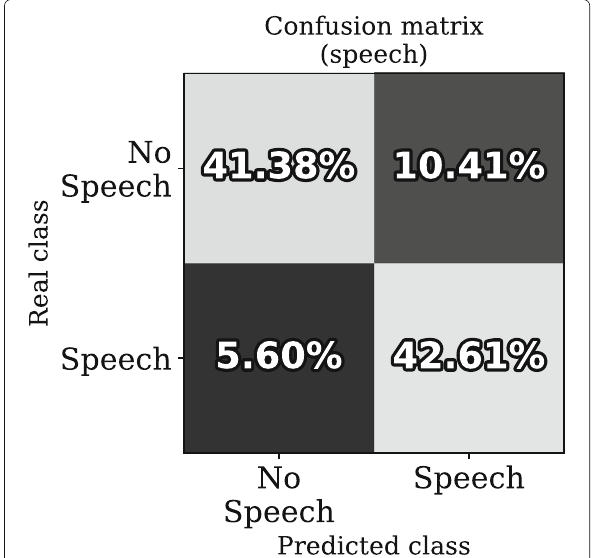
Fig. 5 Confusion matrix of the best network setting for speech event detection (C2-LSTM model with L = 6 and N = 256). The percentages indicate the total amount of test segments in each possible real class-predicted class combination